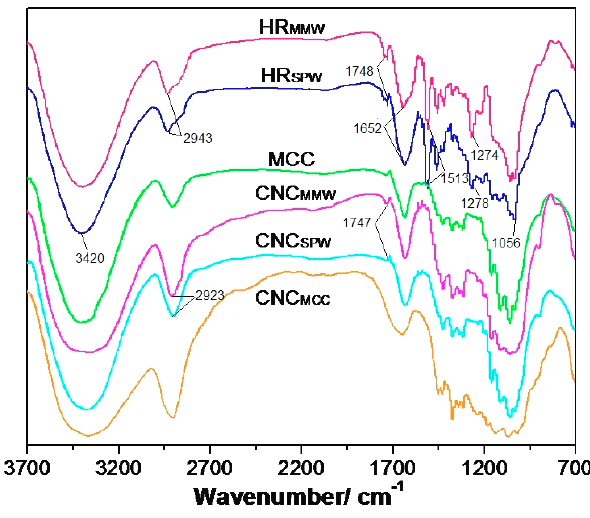
Figure 1. Fourier transform infrared spectroscopy (FTIR) spectra of hydrolyzed residues, MCC, and their cellulose nanocrystals (CNCs).